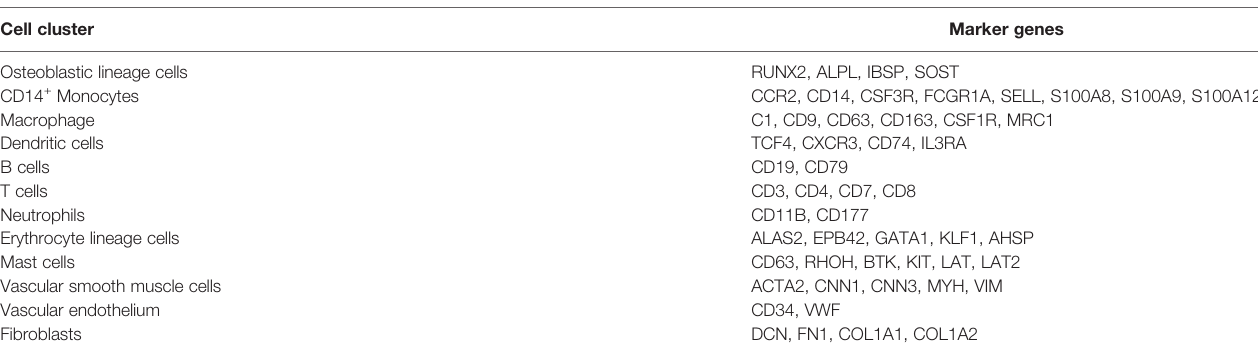
TABLE 2 | The canonical markers for the cell types. Cell